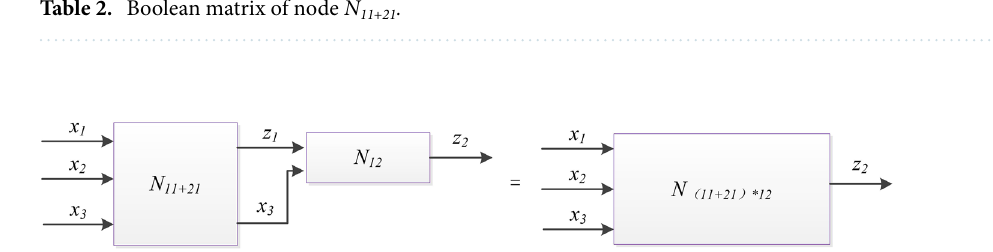
Figure 4. Block-scheme of two nodes’ horizontal merging into one node with 3 inputs and 1